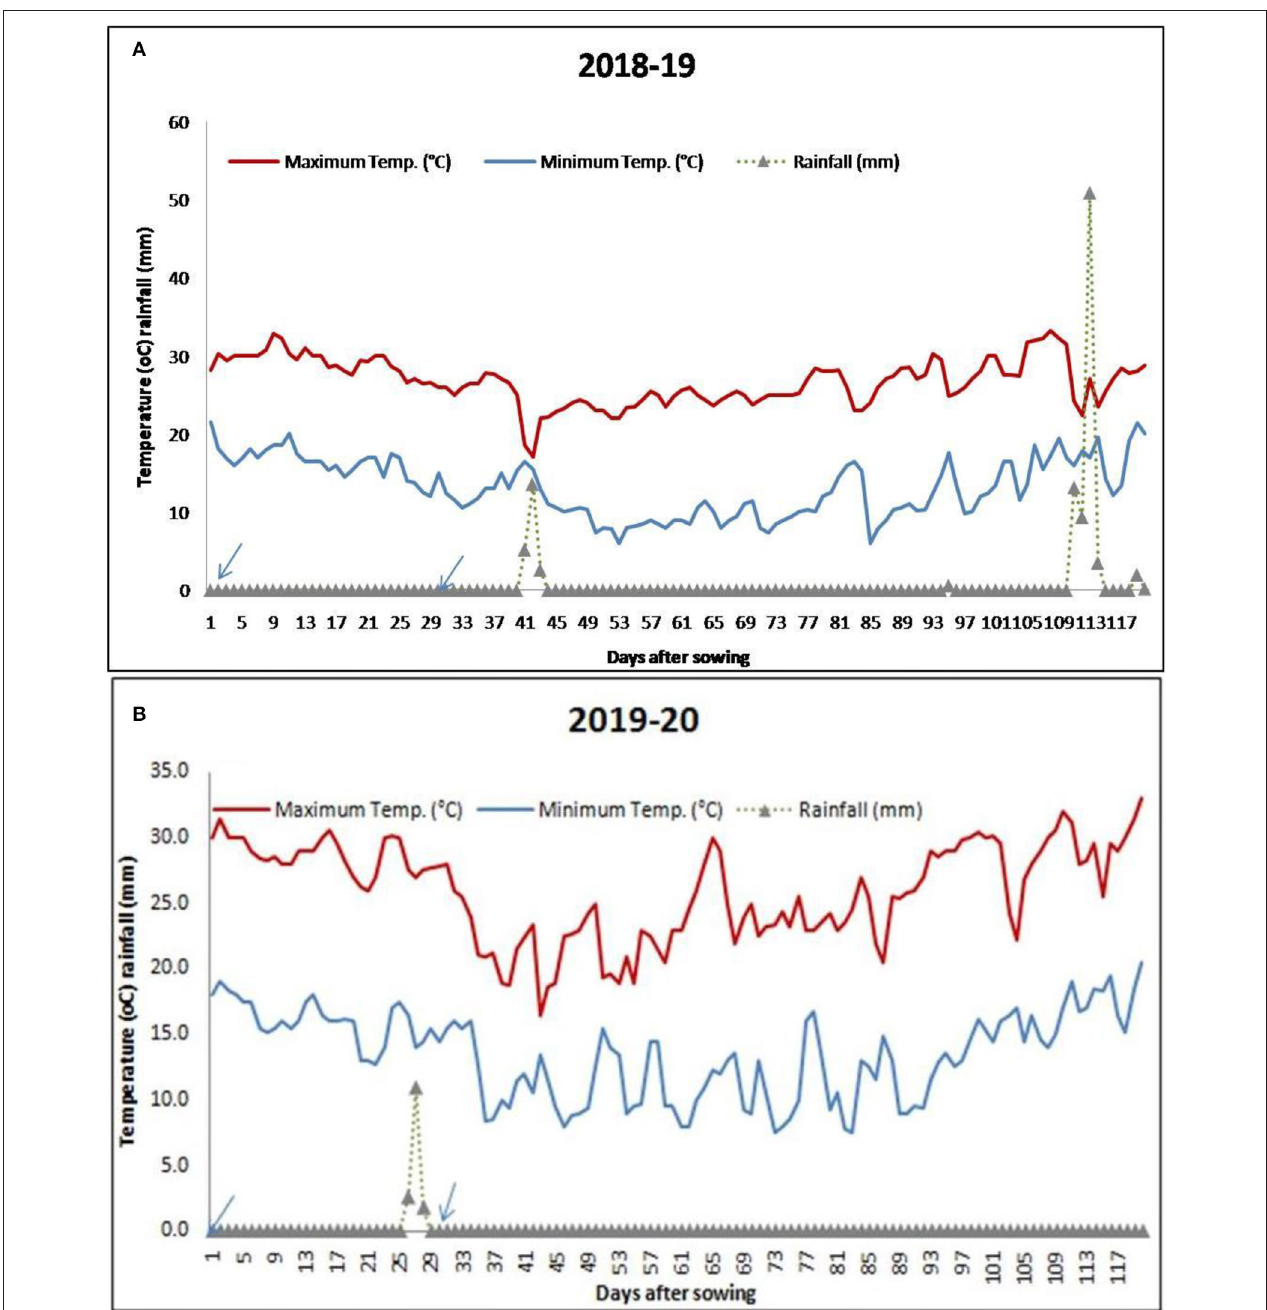
FIGURE 1 | Average daily distribution of temperature and rainfall during the study period [ (A) 2018–2019 and (B) 2019–2020]. Arrows indicate the sowing dates of lentil under November sowing and December sowing.